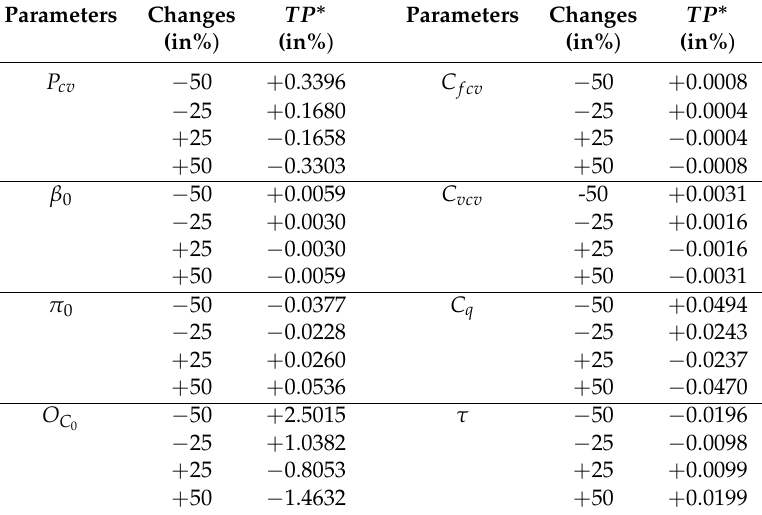
Figure 5. Changes in parameters I h and q versus percentage change in total profit, respectively. Table 8. Sensitivity analysis